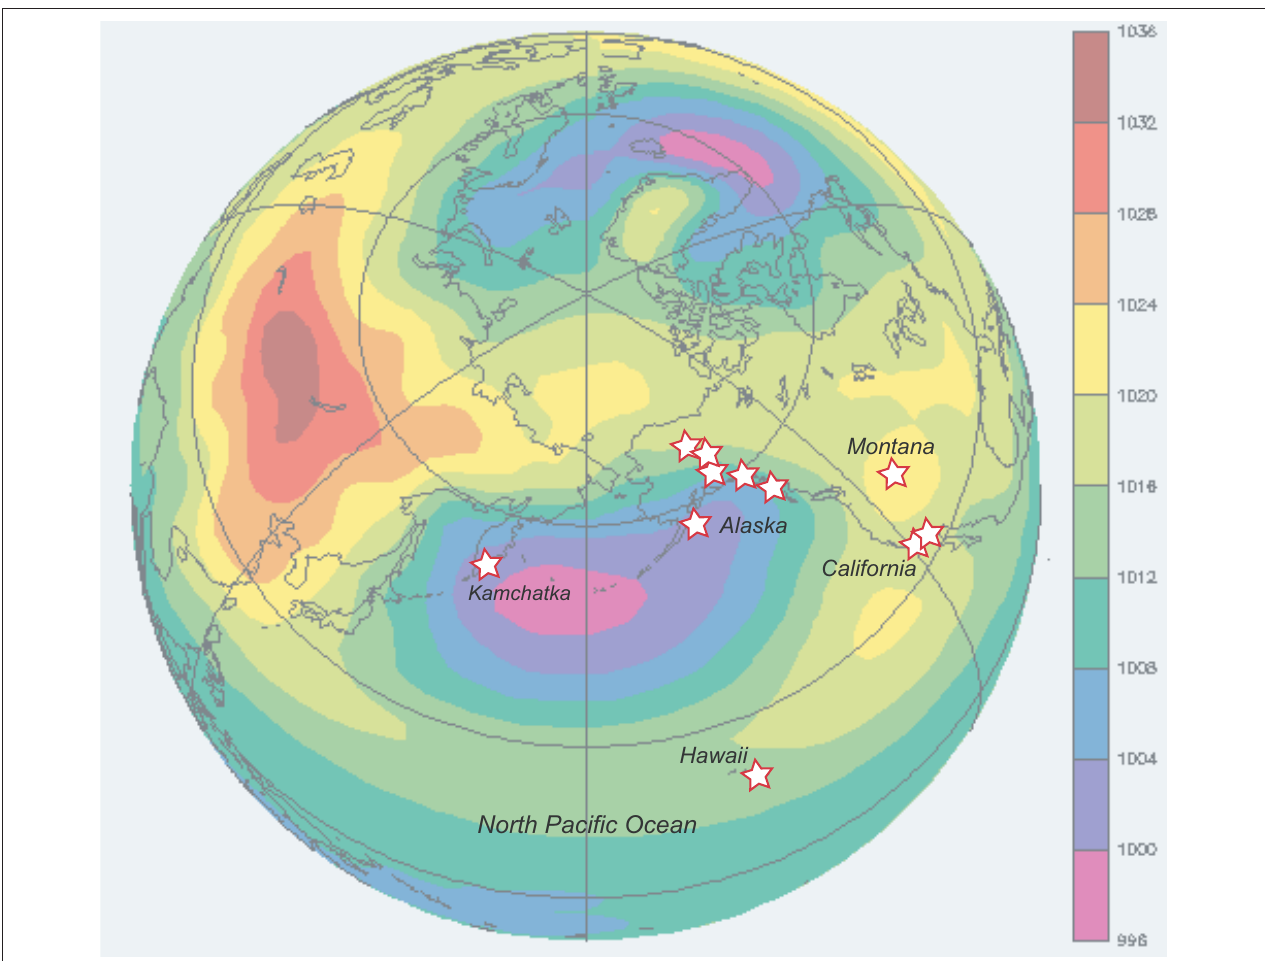
FIGURE 1 | Locations of the North Pacific paleoenvironmental studies included in this volume shown with composite sea level pressure to illustrate their relationship with dominant atmospheric flow patterns. Scale is in millibars (mb) (U.S. National Oceanic and Atmospheric